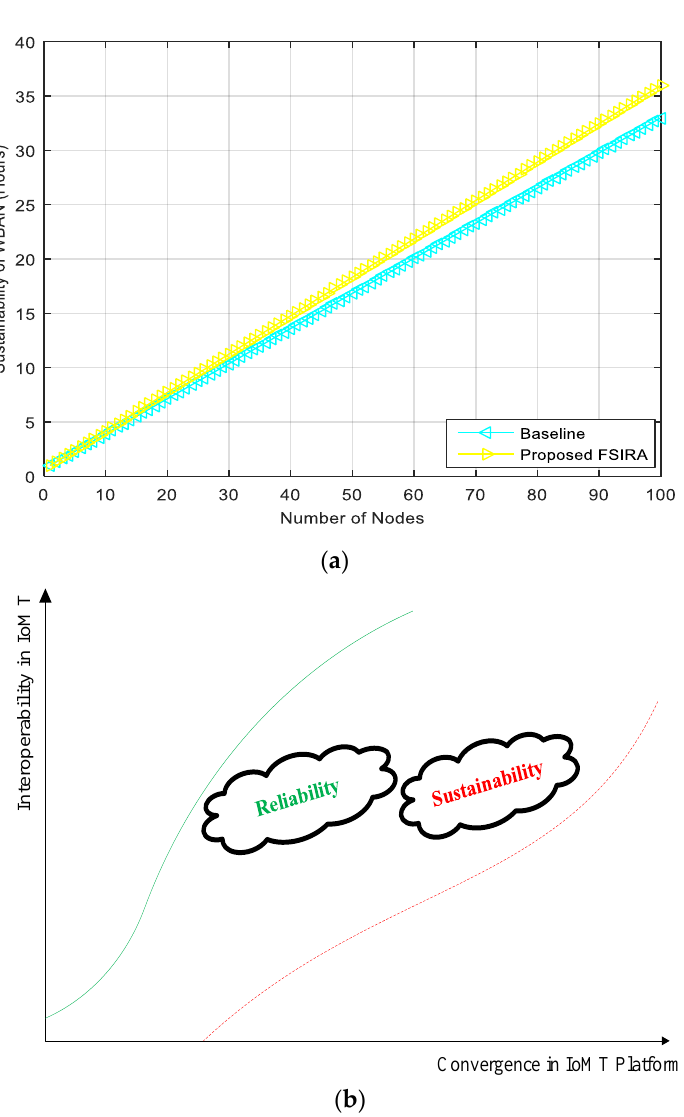
Figure 6. Performance analysis of CPS in connected healthcare.